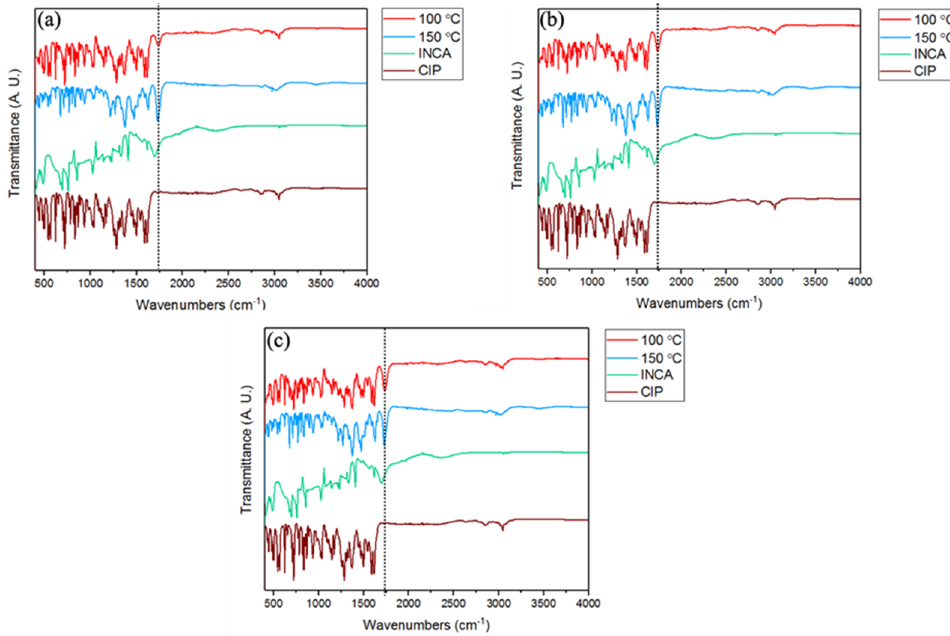
Figure A2. FTIR spectra of samples extruded at various temperatures and screw speeds using kneading screws ( a ) 10 rpm, ( b ) 55 rpm, and ( c ) 100